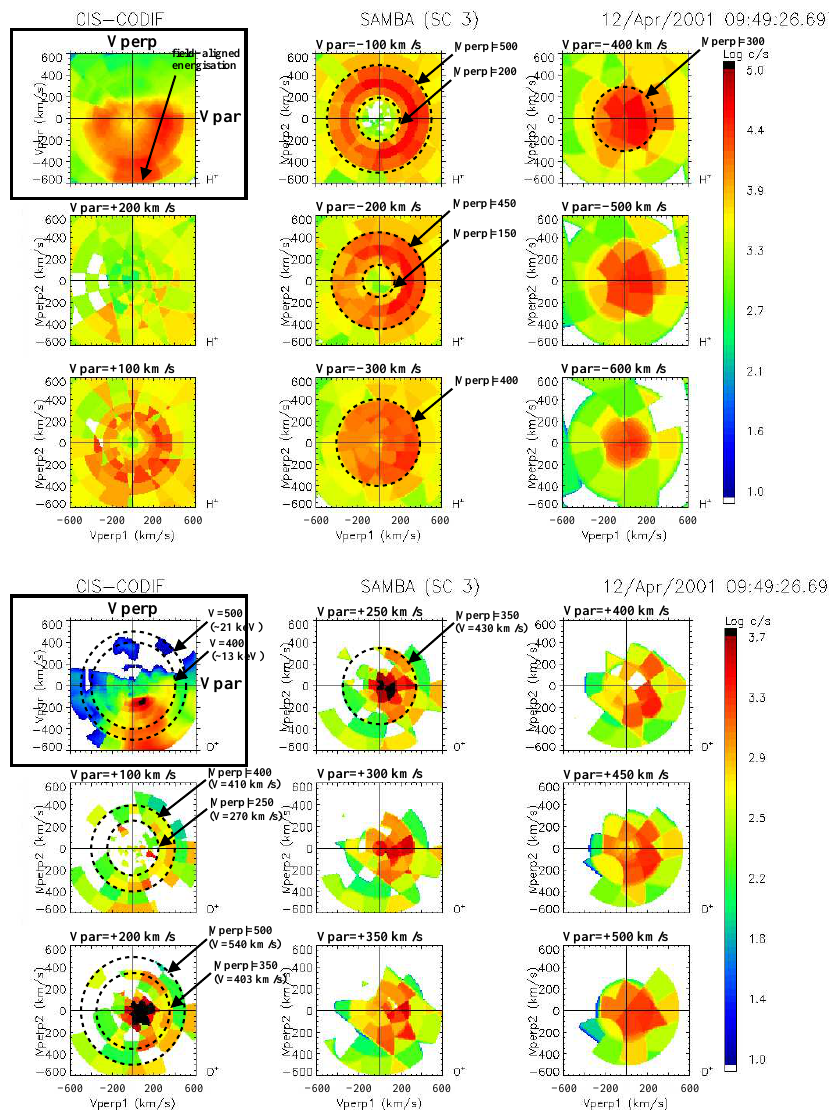
Fig. 2. H + (upper)/O + (lower) ion velocity distributions in counts per second (c/s) observed by the Cluster S/C-3. The − V par direction corresponds to upward direction along the geomagnetic field in this case. The upper left panel in each set of velocity distributions shows a V par - V perp cross section and the other eight panels are cross sections in the V perp plane at different V par